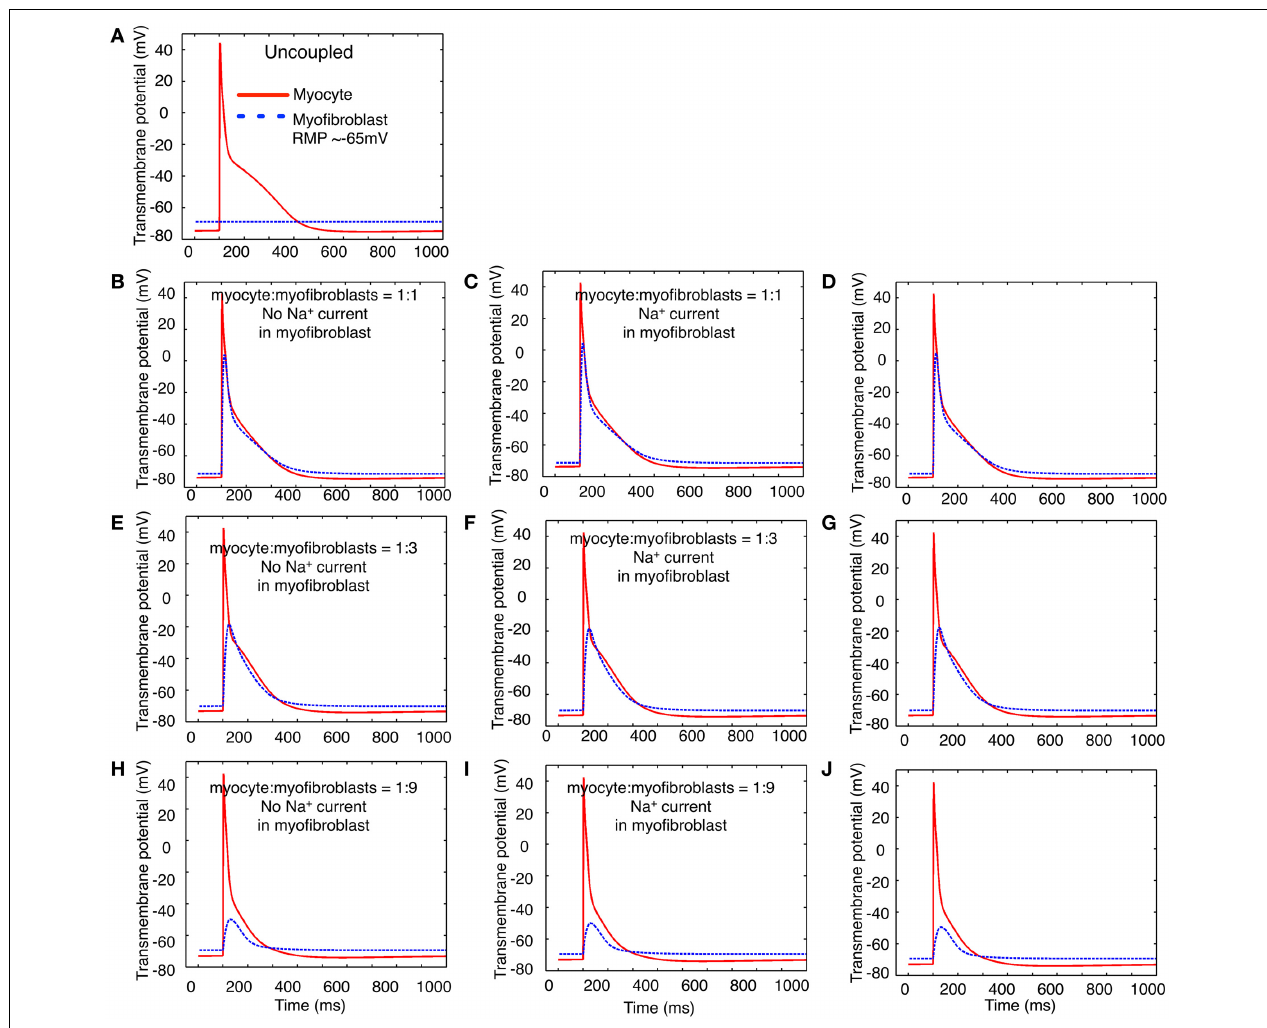
FIGURE 8 | Illustration of the effects of coupling selected numbers of myofibroblasts to 1 human atrial myocyte using an in silico hybrid model similar to the one first described by Maleckar et al. (2009a), assuming a myofibroblast resting potential of − 65mV. The layout of this Figure is the same as that of Figure 7 .